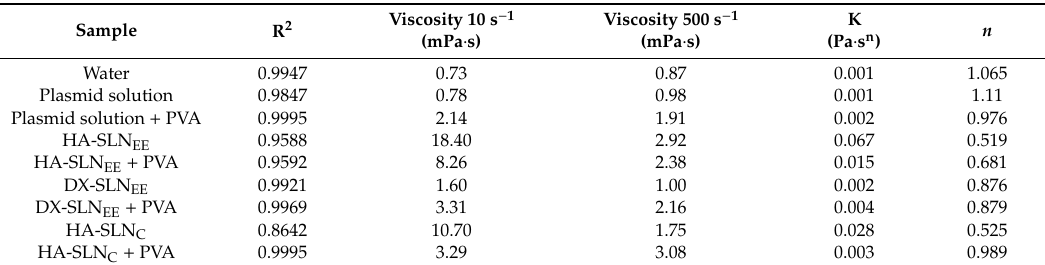
Table 3. High coe ffi cient of determination (R 2 ), viscosity (mPa · s) at shear rate of 10 and 500 s − 1 , consistency coe ffi cient (k; Pa · s n ) and flow behavior index (n) values of vectors and plasmid Table 3 . High coefficient of determination (R 2 ), viscosity (mPa ∙ s) at shear rate of 10 and 500 s − 1 , pcDNA3-EGFP solution with and without consistency coefficient (k; Pa ∙ s n ) and flow behavior index (n) values of vectors and plasmid pcDNA3- EGFP solution with and without PVA.